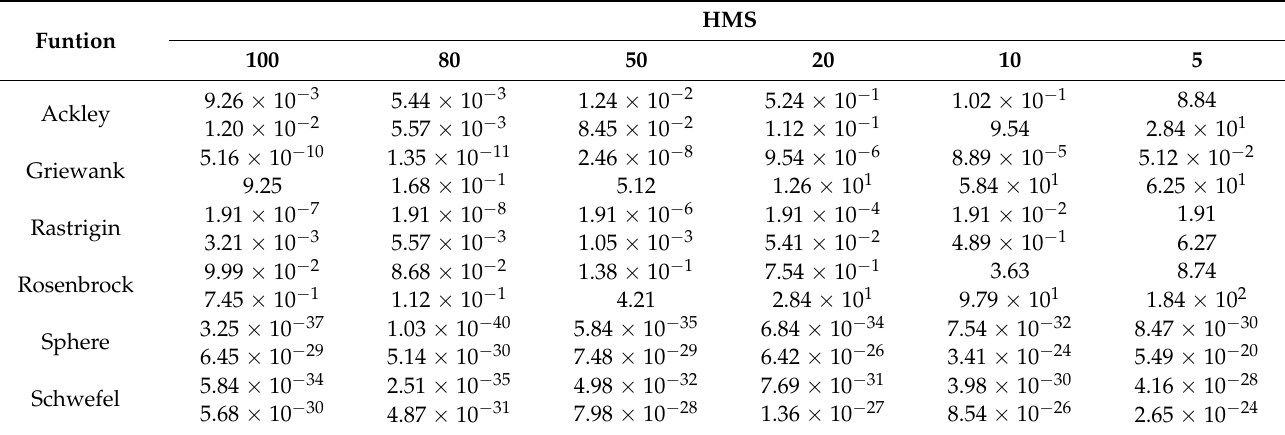
Table 2. Effects of HMS on performance of RDEGA-HS (HMCR =